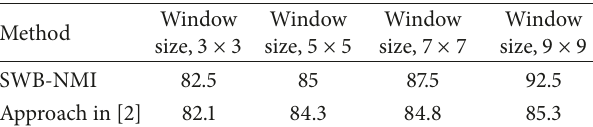
Table 5: Change detection result based on SWB-NMI and tradi- tional MI used in [3]. Methods